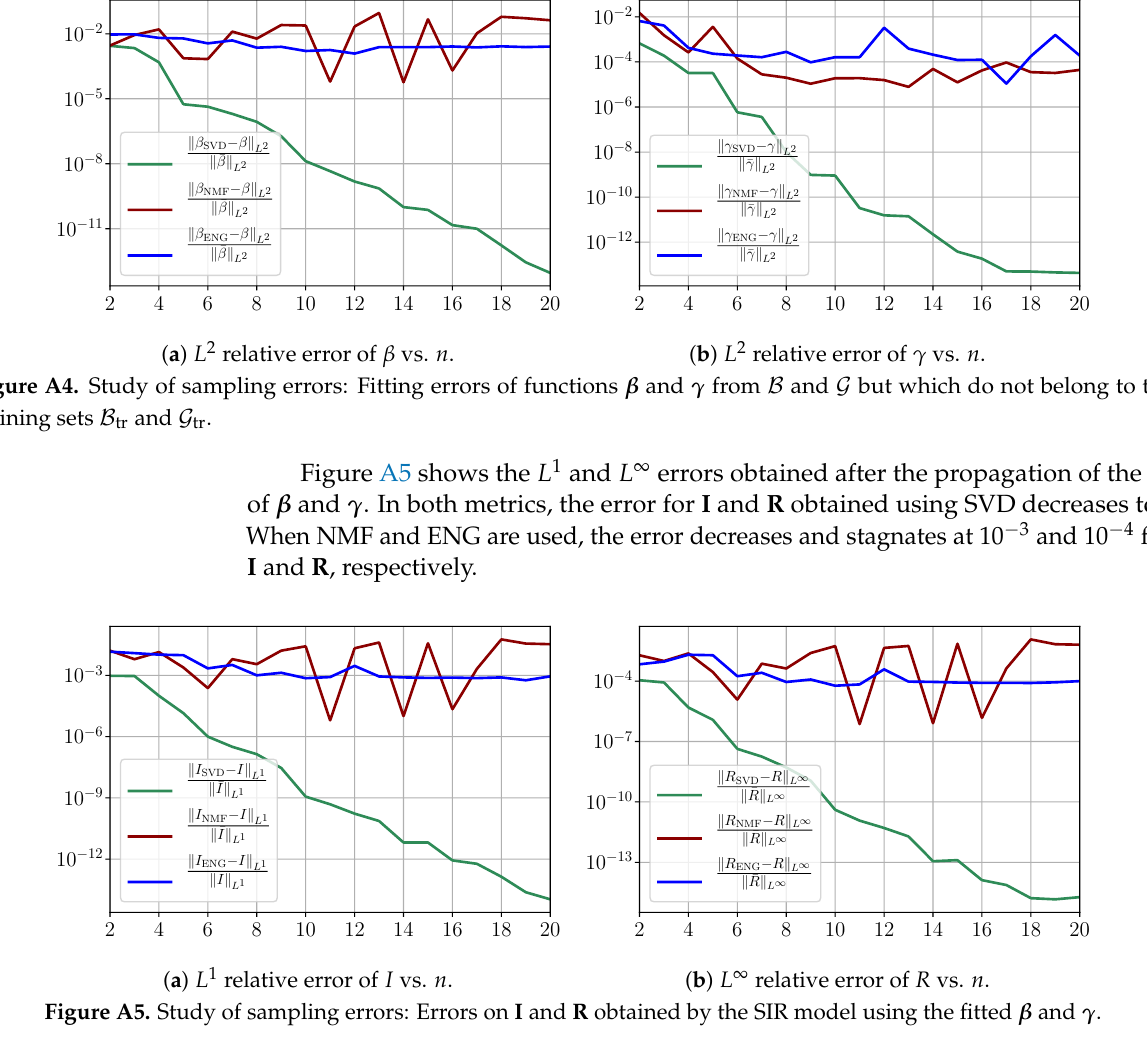
Figure A5. Study of sampling errors: Errors on I and R obtained by the SIR model using the fitted β and γ